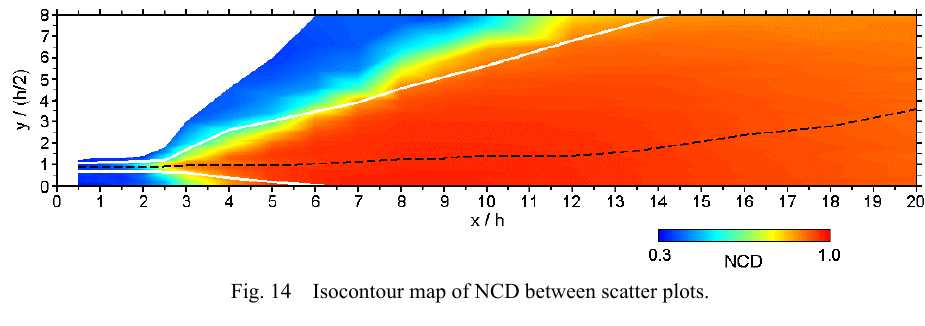
Fig. 14 Isocontour map of NCD between scatter plots.